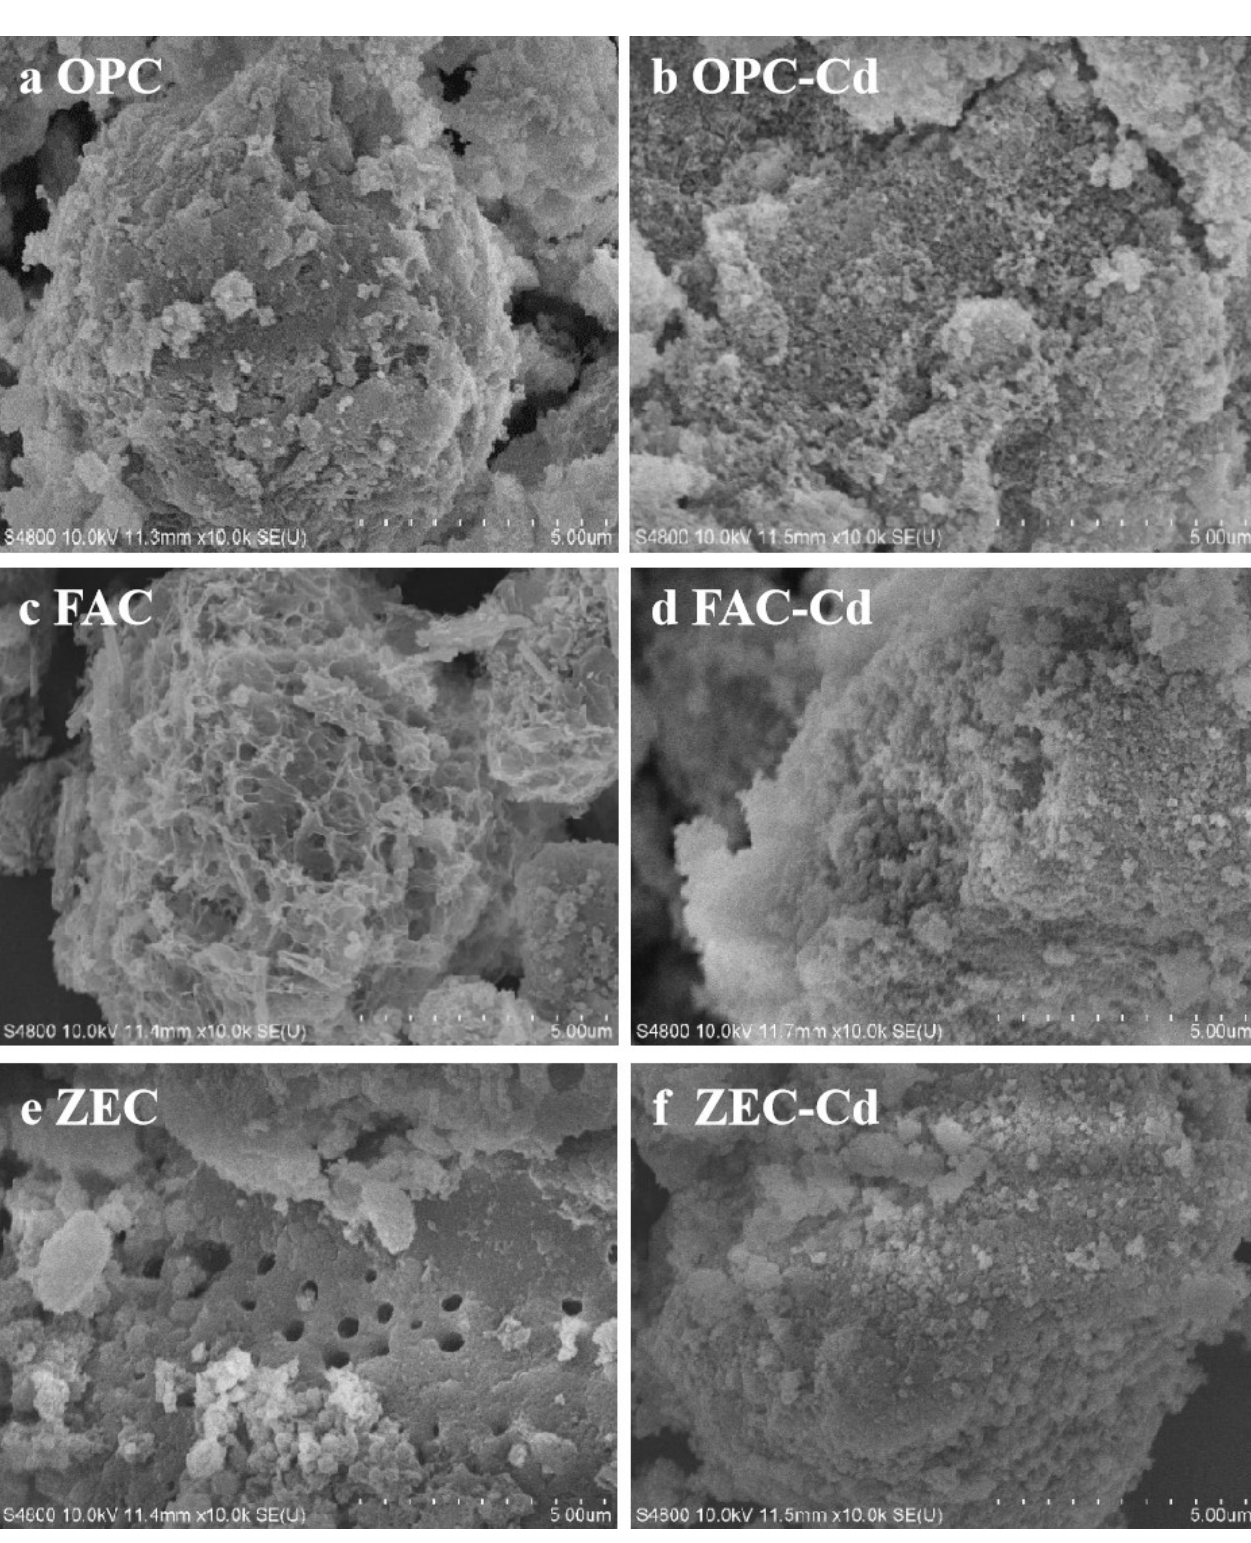
Figure 2. SEM images of Cd 2+ adsorption with cement paste (OPC), fly ash cement (FAC) paste, and zeolite cement (ZEC) paste: ( a , c , e ) before adsorption of Cd 2+ ; ( b , d , f ) after adsorption of Cd 2+ in the aqueous